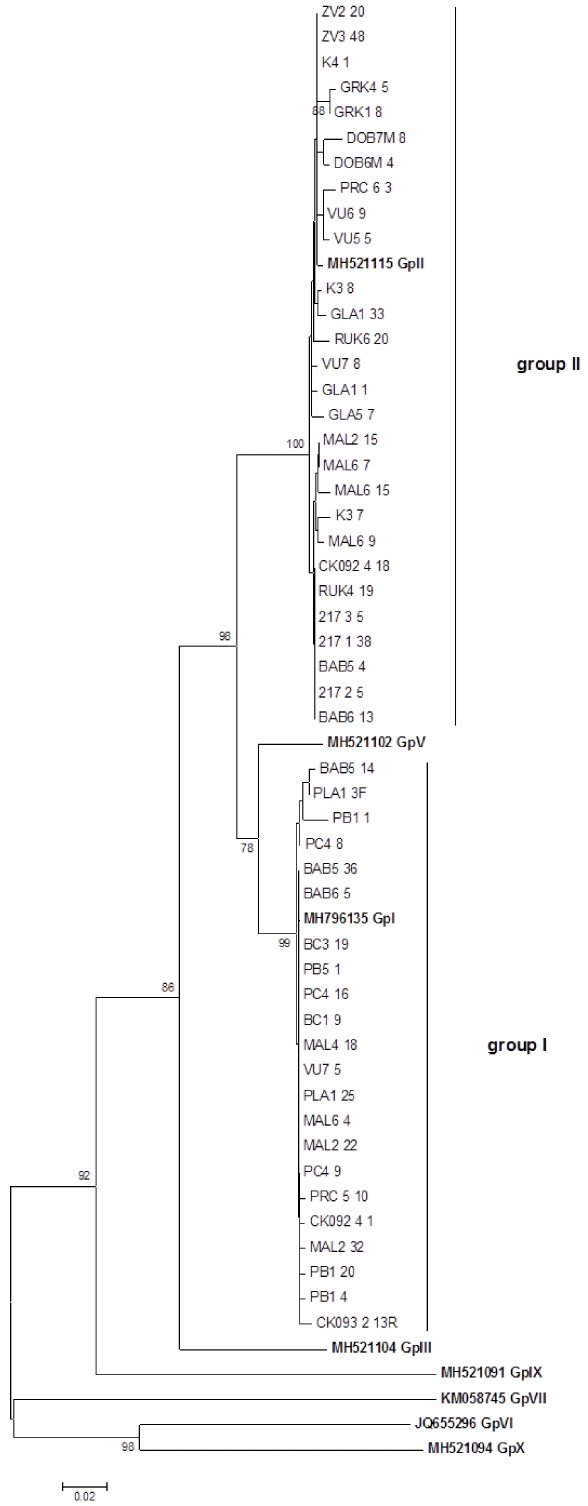
Figure 6. Neighbor-joining phylogenetic tree obtained by the analysis of GLRaV-3 heat shock 70 protein homologue (HSP70h) nucleotide sequences of tested field isolates. Phylogenetic analysis was performed by MEGA 5. The bar represents 0.02 nucleotide substitutions per site. Reference sequences included in the analysis are in bold. Clusters are determined in accordance with the phylogenetic groups published by Diaz-Lara et al.